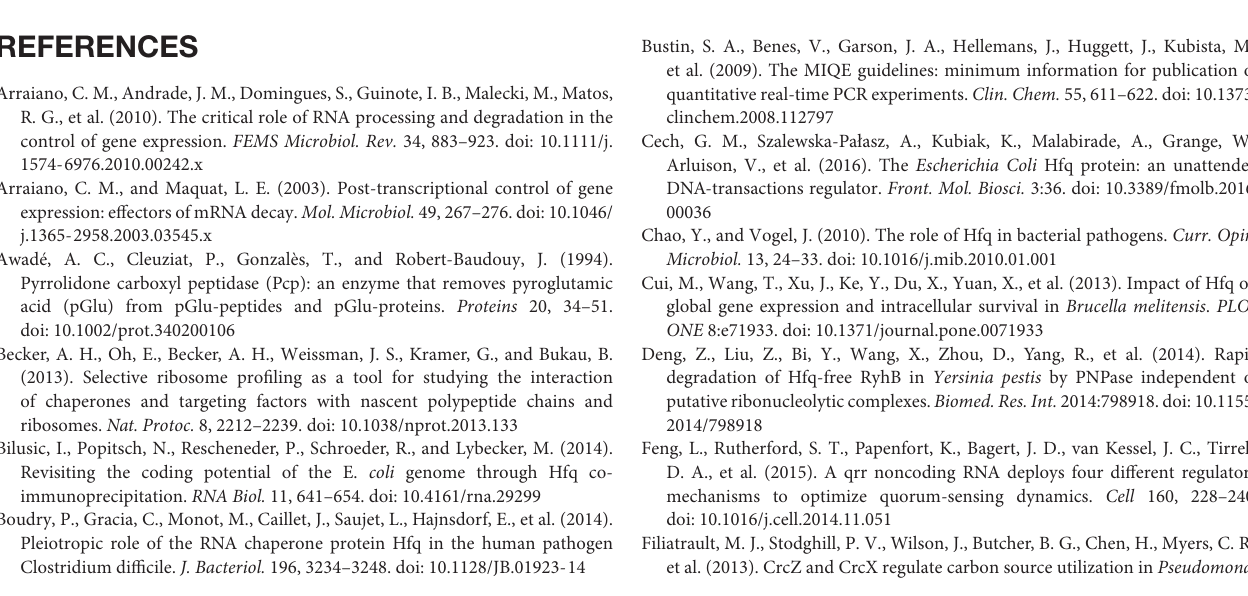
TABLE S1 | Parallel global analyses of the P. fluorescens hfq null mutant. TABLE S2 | ncRNAs analysis. TABLE S3 | Correlation between Hfq transcriptome and translatome. TABLE S4 | Integration of the regulatory datasets. TABLE S5 | Strains and plasmids. TABLE S6 |